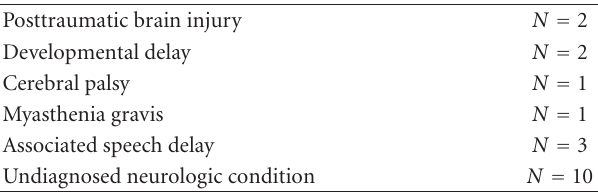
Table 1: Neurologic causes of noncleft VPI.